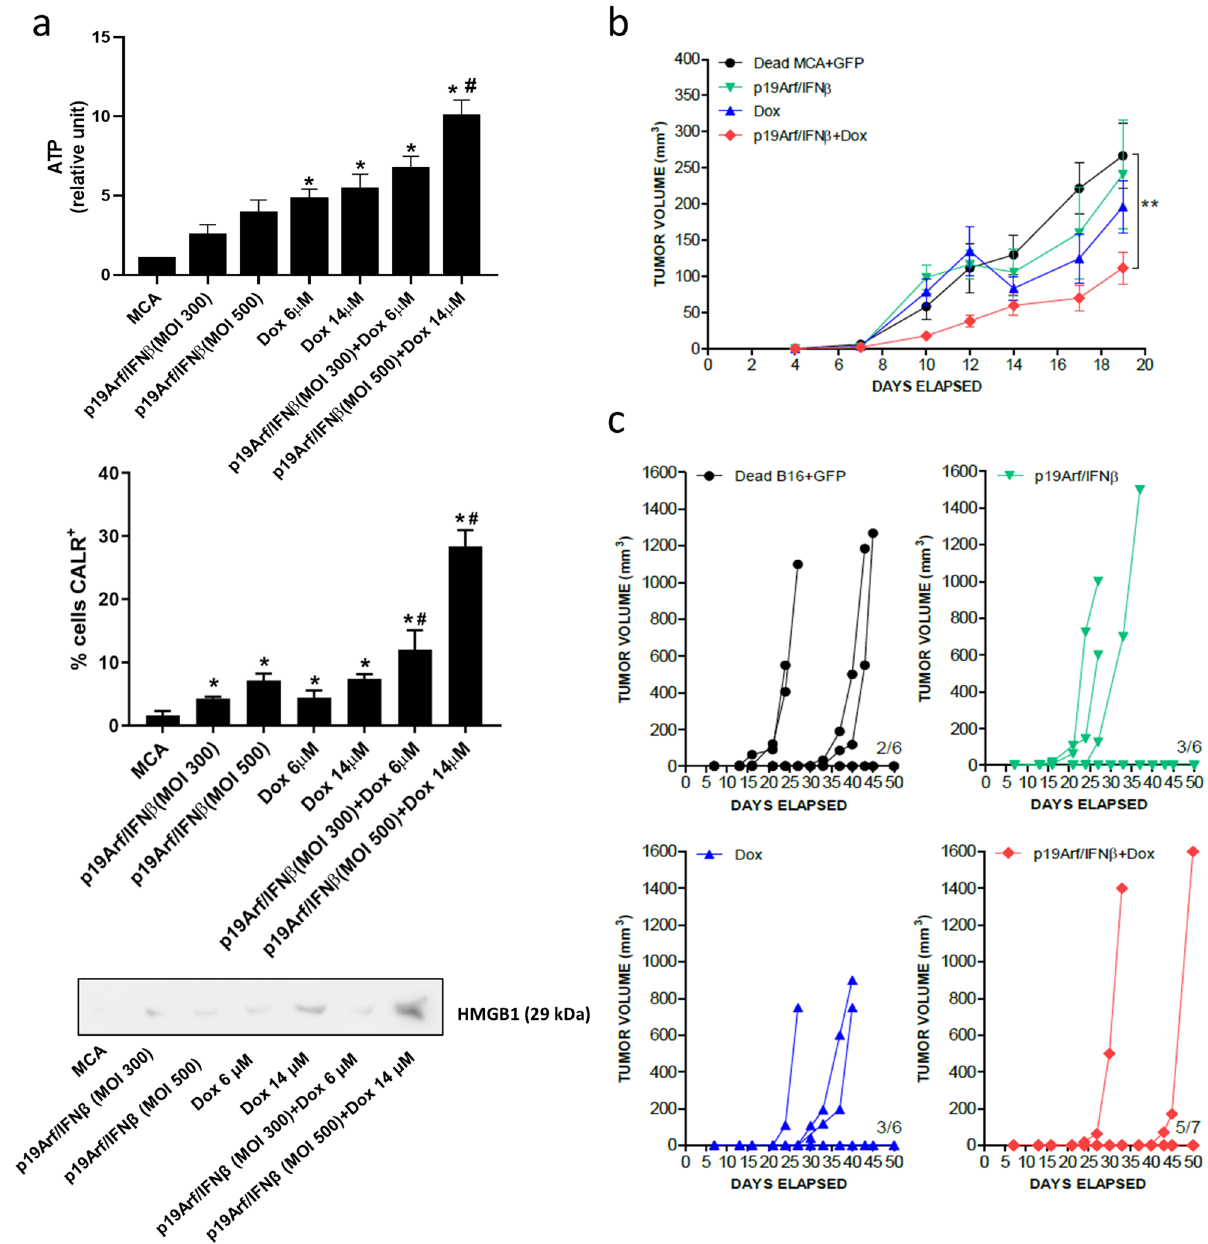
Figure 4. p19Arf/IFNβ and doxorubicin association potentiates immunogenicity of treated cancer cells. ( a ) Detection of ICD-related DAMPS in the MCA cell line: ATP (secreted, detected by ELISA), calreticulin (CALR, cell surface detection by flow cytometry) or HMGB1 (secreted, detected by western blot of cell concentrated cell supernatant). For ATP and CALR, each assay performed on 3 independent occasions with technical duplicates. One-way Anova with Sidak’s post-test. *p < 0.0001 vs CTR; # p < 0.0001 p19Arf/IFNβ + Dox vs p19Arf/IFNβ or Dox The western blot was performed on 3 independent occasions; a representative image is presented. ( b ) MCA tumors were established (s.c.) before immunotherapy was performed using MCA cells treated ex vivo as indicated. Impact of immunotherapy on progression of challenge MCA tumors was monitored. [Two-way Anova and Bonferroni post-test] n = 6 for all groups, except for p19Arf/IFNβ + Dox where n = 7. **p < 0.001 p19Arf/IFNβ + Dox vs Dead MCA + GFP. ( c ) B16 tumors (s.c.) were established then immunotherapy performed using B16 cells treated ex vivo as indicated. Progression of the s.c. (challenge) tumors were